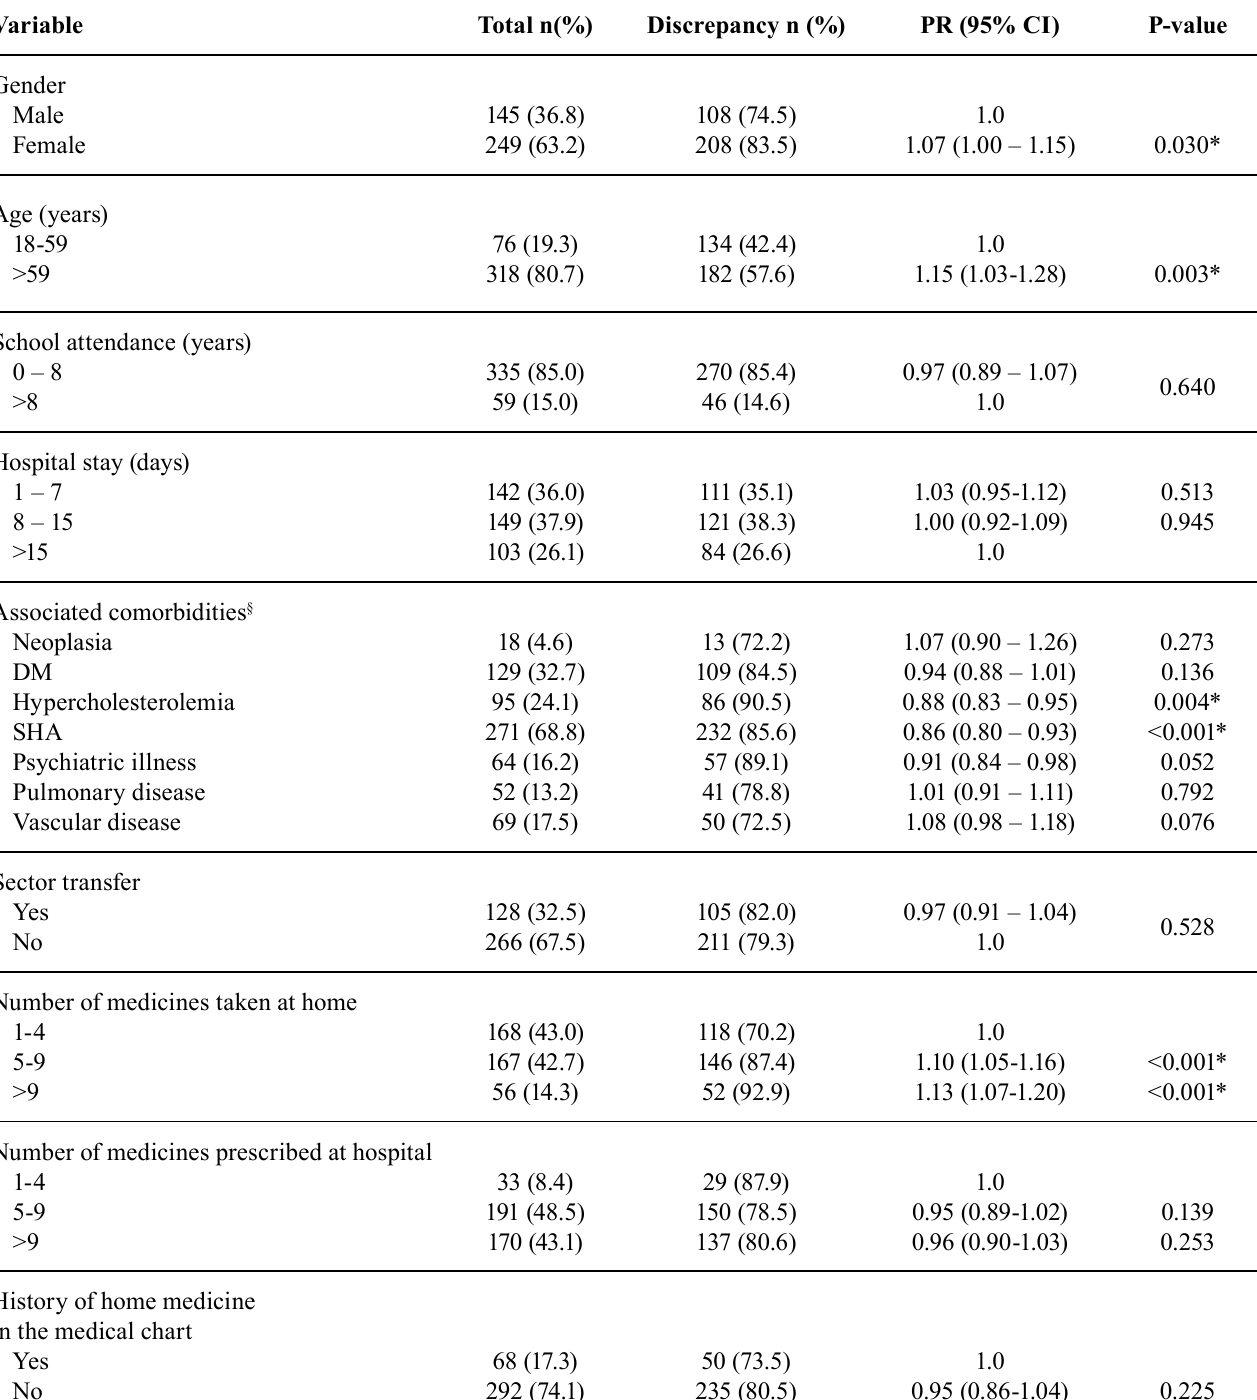
TABLE I – A nalysis of the association between sociodemographic and clinical variables and medication discrepancies in the surveyed hospital, 2015-2016 (n =